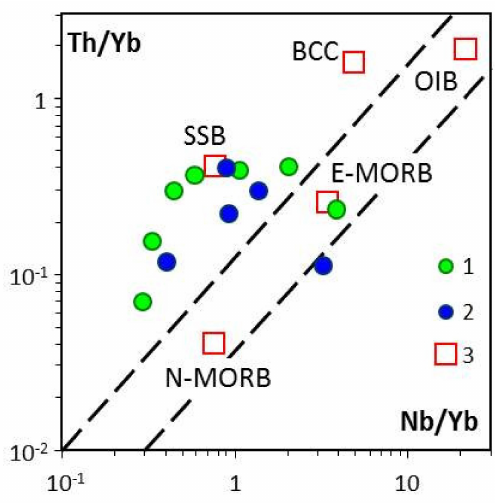
Figure 14. Ophiolitic gabbro in the Th / Yb-Nb / Yb diagram. 1 = type 1 gabbro; 2 = type 2 gabbro; 3 = average ratios in basalts of di ff erent tectonic settings: N-MORB and E-MORB = mid-ocean ridge [59], OIB = oceanic islands [59], SSB = supra-subduction [60], BCC = bulk continental crust